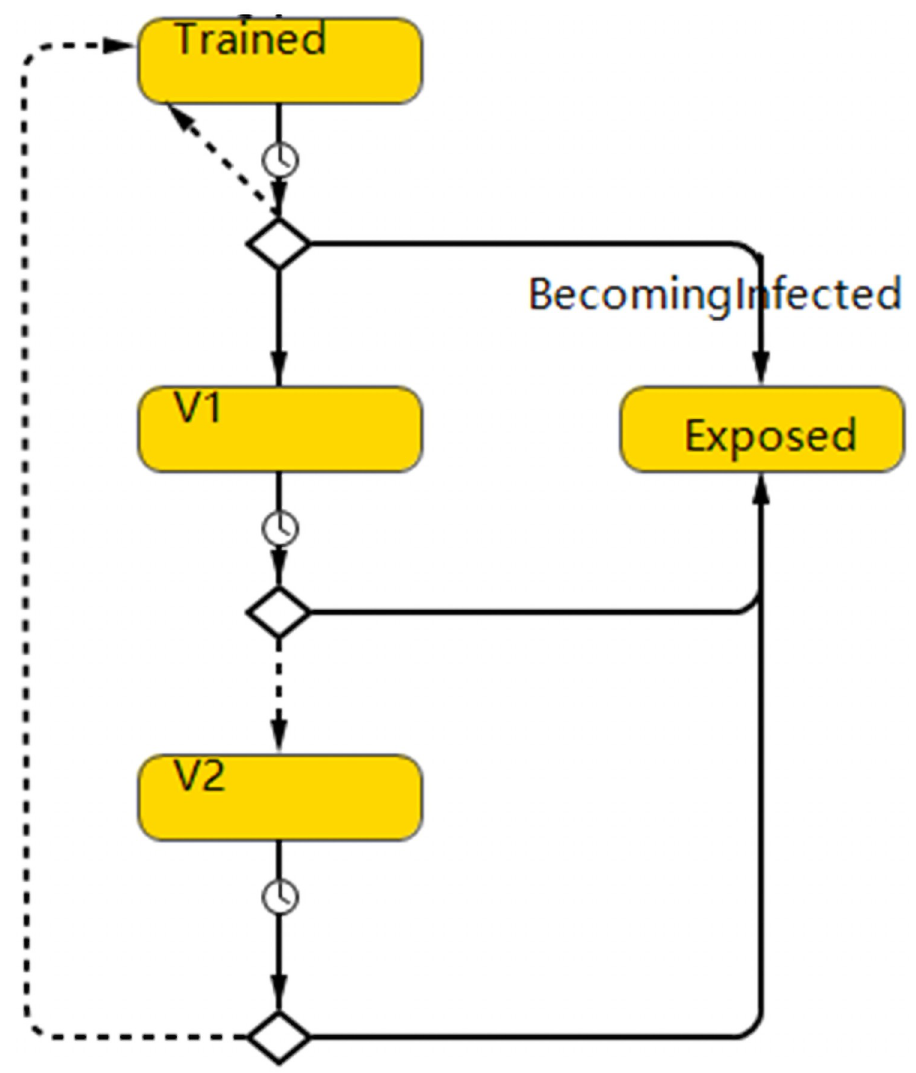
Fig 4. The vaccination module in the agent-based model. “V1” represents HCWs who have already vaccinated but the efficacy of vaccine has not been onset yet. “V2” means HCWs who are protected by the effective vaccine.